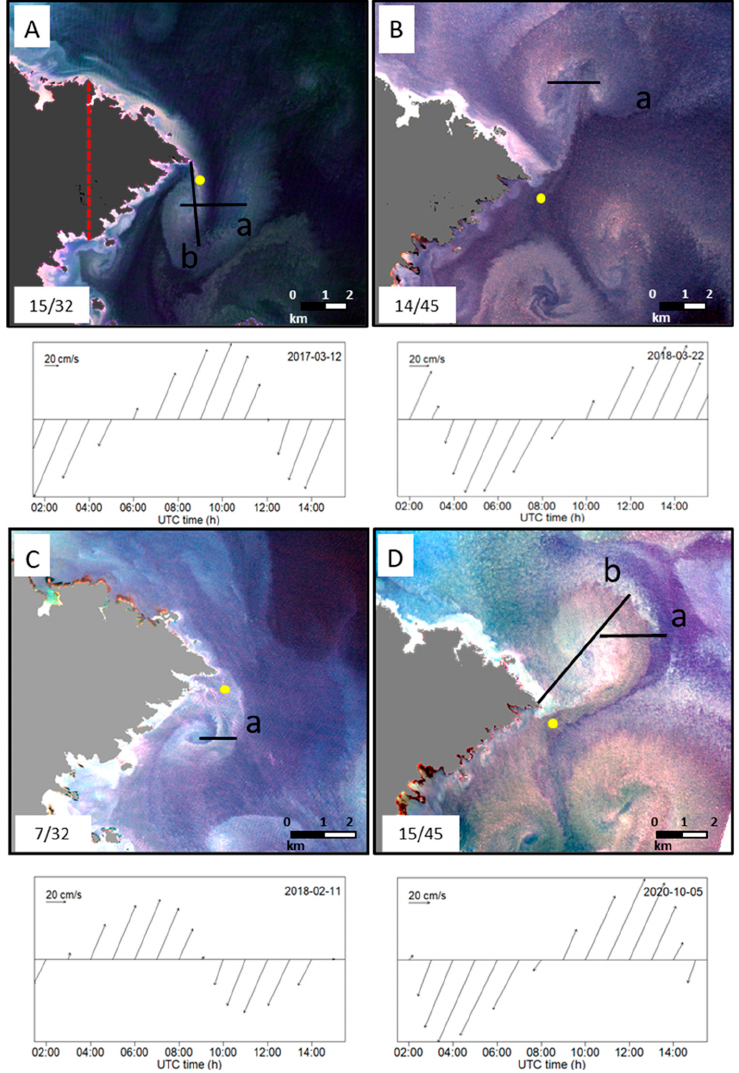
Figure 3. Structures in Dos Bahías Cape (DBC), the red line shows the measured point for the North –South dimension. ( A ) Mushroom-like pa tt ern south of DBC, after 2 h of SSW tidal current. ( B ) Mushroom-like pa tt ern north of DBC, after 5 h of NE tidal current. ( C ) Cyclonic isolated eddy south of DBC, after 5 h of SSW tidal current. ( D ) Anticyclonic isolated eddy north DBC, after 6 h of NNE tidal current. Black lines indicate how the structures were measured, being (a) width of mushroom- like pa tt erns or isolated eddies and (b) distance from Dos Bahías Cape. Numbers in the lower left corner represent the number of scenes showing this particular structure (linked with Table 1). The arrow time series below each image represents the tidal current velocities 12 h prior to the acquisi- tion of the image as extracted from TPXO data at the locations marked by yellow points on the corresponding image. According to the time elapsed, t, since the last tidal current rotation, this structure passes periodically through di ff erent phases: appearance, evolution, restructuring, and